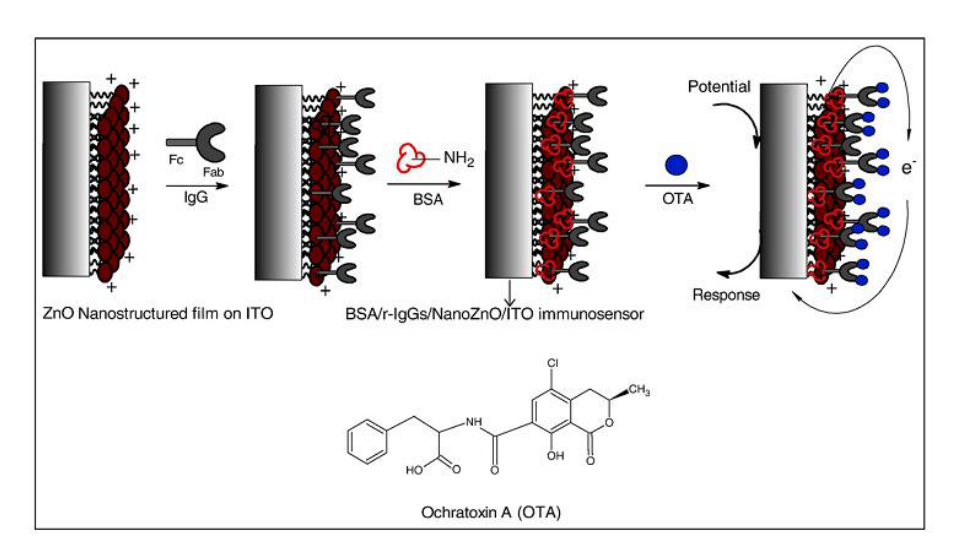
Figure 3. Schematic of the fabrication of a BSA/r-IgGs/Nano-ZnO/ITO immunosensor along with the biochemical reaction between ocratoxin-A (OTA) and